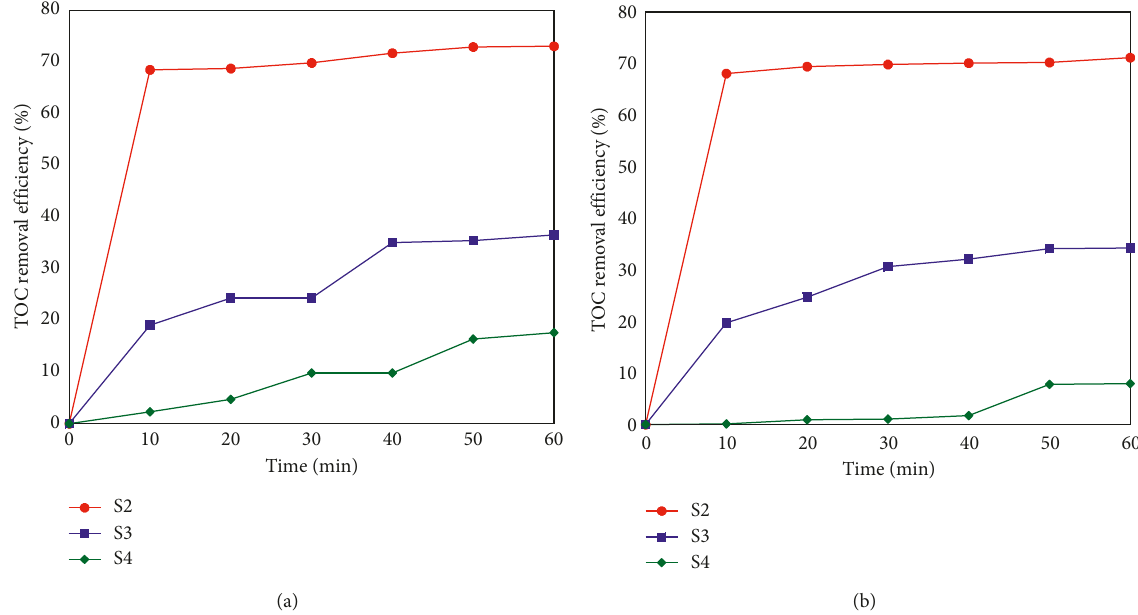
Figure 5: Removal efficiency of TOC for an EC process with (a) Fe electrode and (b) Al electrode. Conditions: pH 7.0; S2 (tanning), S3 (retanning), and S4 (mixture) wastewater; electrolysis time � 60min.